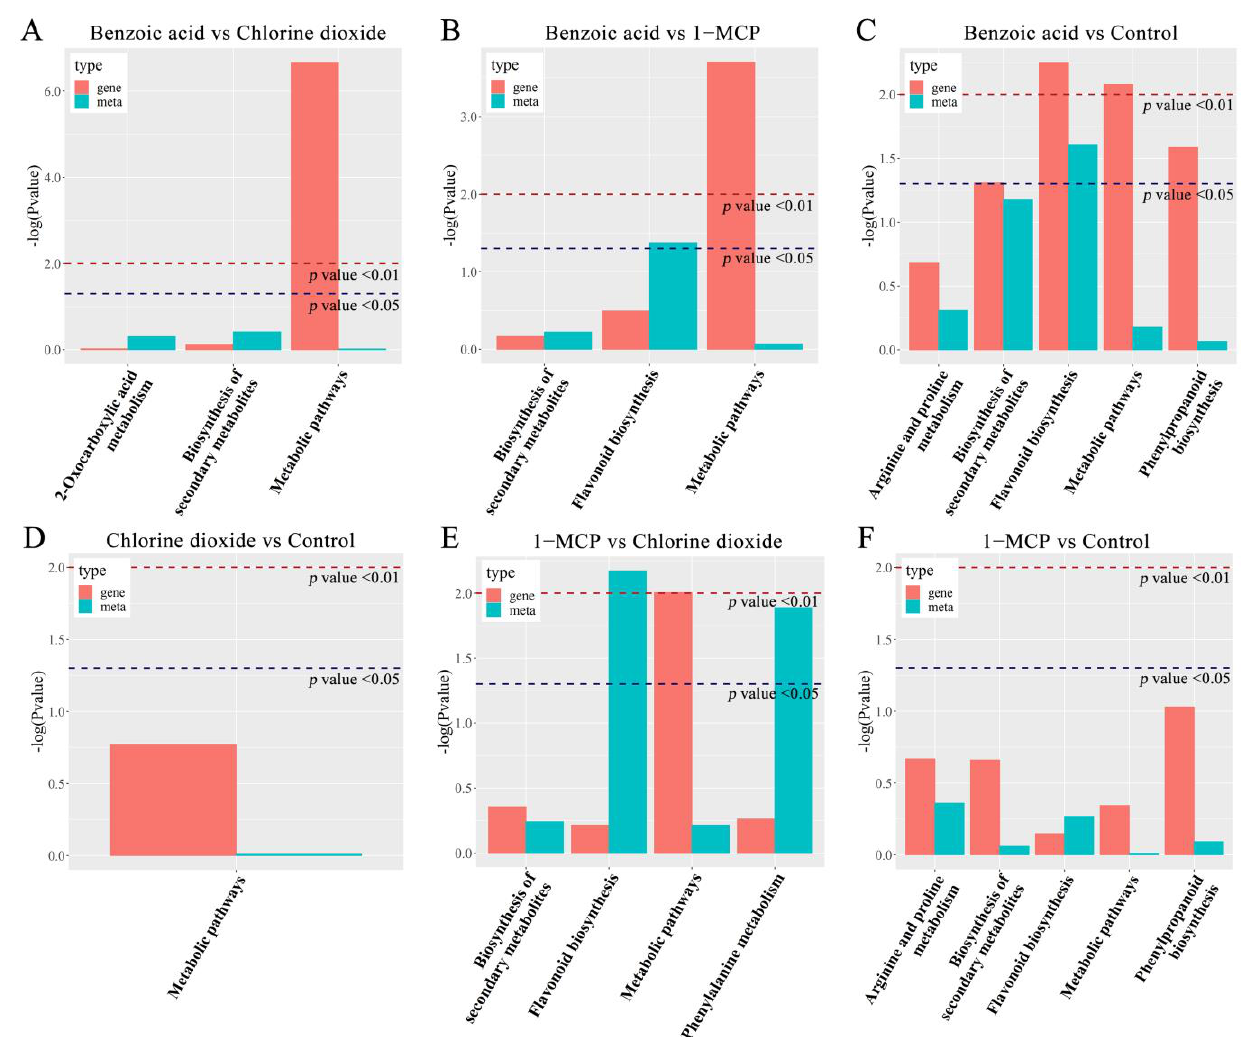
Figure 5. KEGG pathway enrichment analysis of DAMs and DEGs in different combinations of Benzoic acid vs. Chlorine dioxide ( A ), Benzoic acid vs. 1-MCP ( B ), Benzoic acid vs. Control ( C ), Chlorine dioxide vs. Control ( D ), 1-MCP vs. Chlorine dioxide ( E ), 1-MCP vs. Control ( F ). The x -axis is the enrichment pathway, while red and green on the y -axis are the p -values of DAMs and DEGs, respectively.